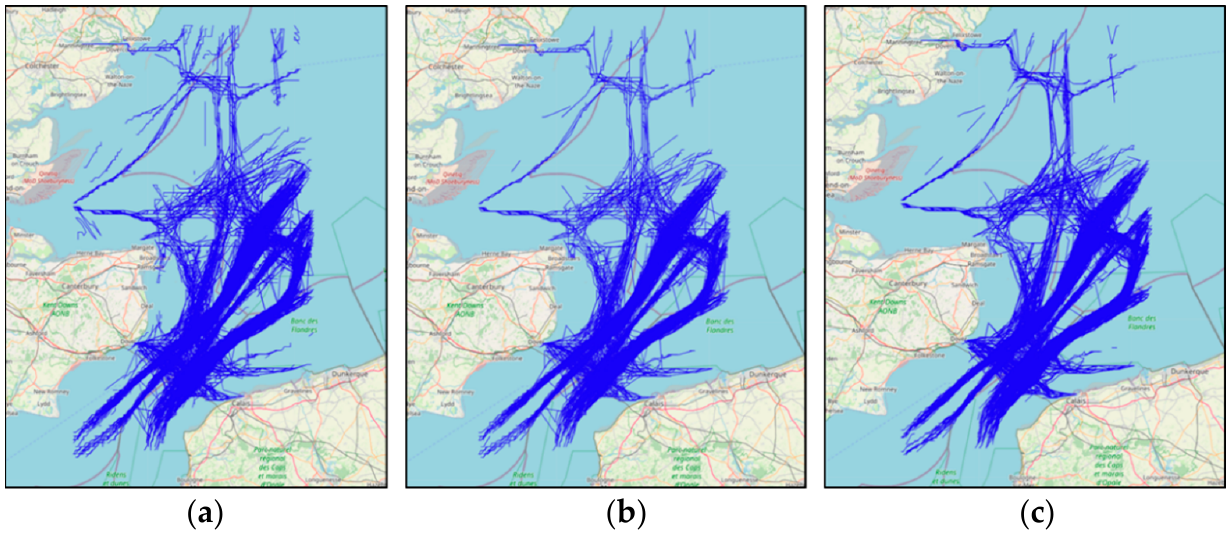
Figure 9. Comparison of denoising and reconstruction effects in Strait of Dover water. ( a ) Data preprocessing; ( b ) data cleaning; ( c ) trajectory reconstruction. Table 3. Information on the Strait of Dover water trajectories. Dataset Raw Data Set